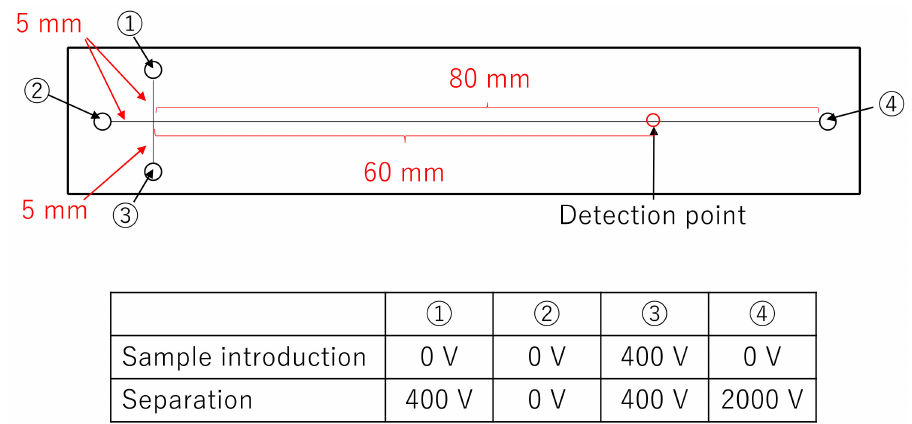
Figure 3. The sizes of microchannel in the microchip and the positions of voltage application during sample introduction and separation in the